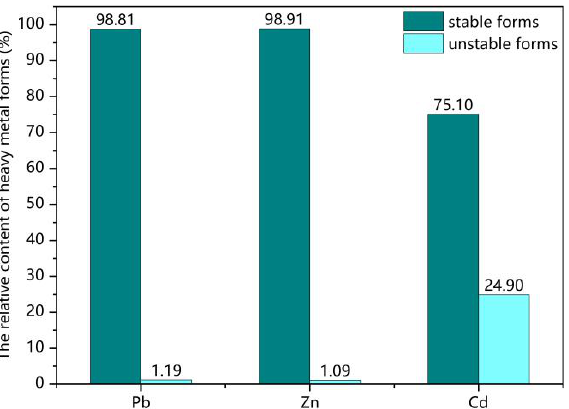
Figure 3. The relative content of heavy metals (HMs) in the solidified/stabilized (S/S) Pb – Zn – Cd composite HM-contaminated soil without F – T cycles.